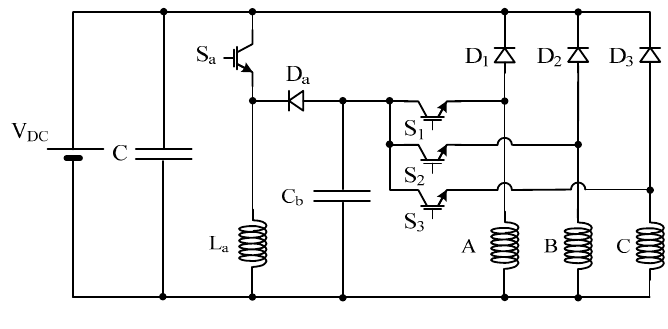
Figure 10. Buck-Boost topology.